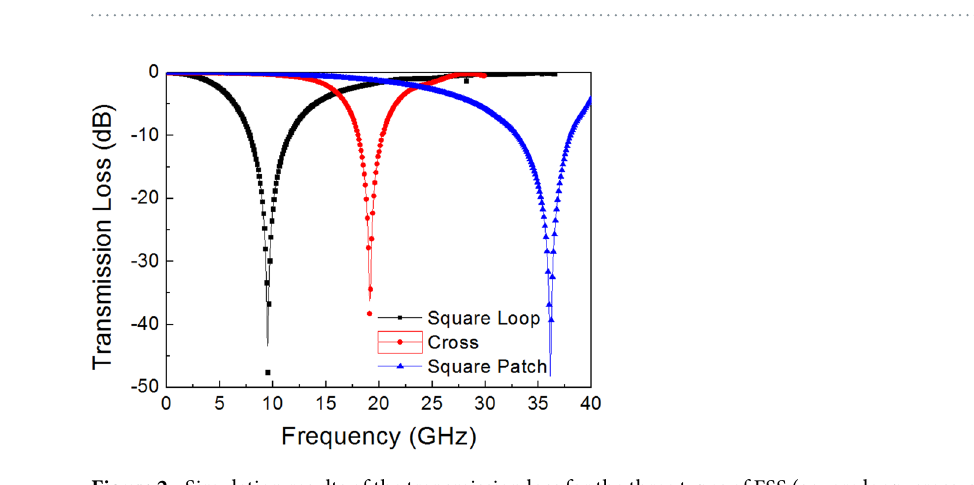
Figure 1. Schematic of the three types of FSSs and their dimensions: ( a ) square loop FSS (p = 7.5 mm, d = 7.0 mm, s = 0.3 mm), ( b ) cross FSS (p = 7.5 mm, d = 7.0 mm, s = 0.3 mm), and ( c ) square patch FSS (p = 7.5 mm, d = 4.5 mm).